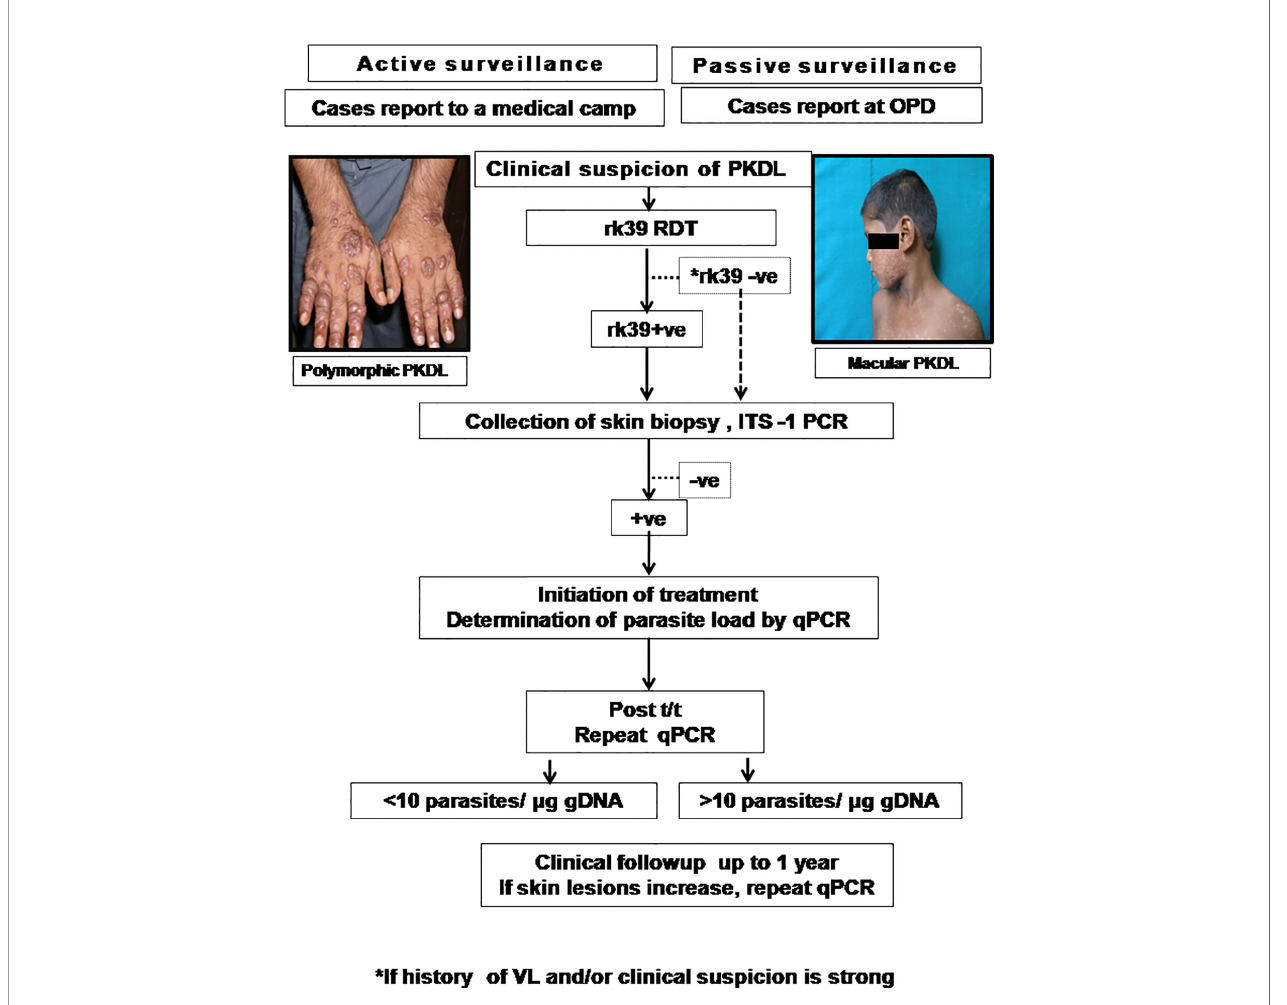
FIGURE 2 | Proposed algorithm for diagnosis of